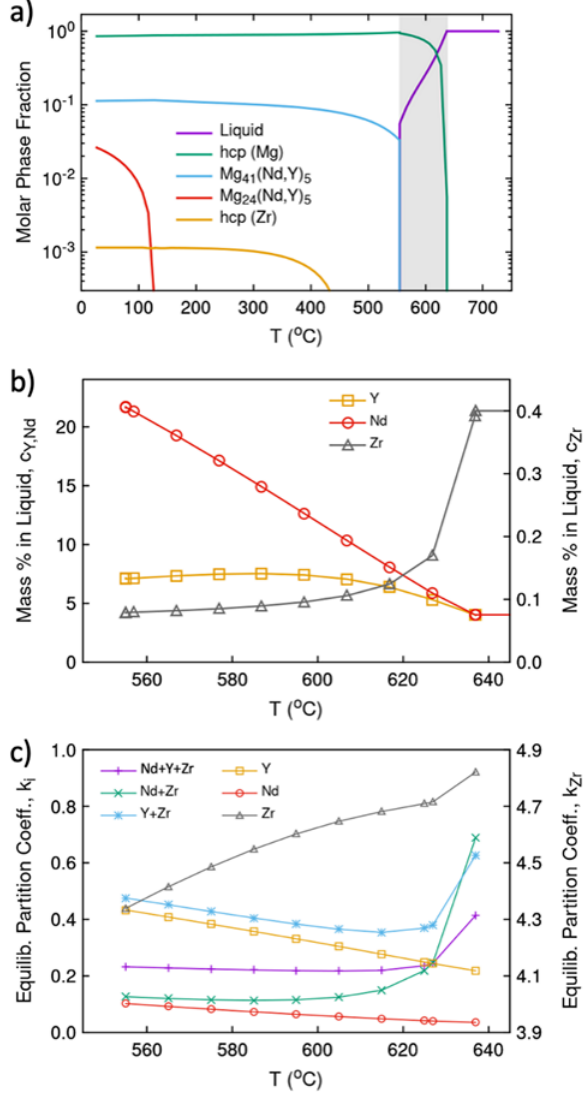
Figure 10. Computational thermodynamic analysis of WE43 solidification in equilibrium. ( a ) Property diagram showing molar-phase fractions, with the shaded area illustrating the solid–liquid coexistence region. ( b ) Elemental mass % on the liquid side of the solid–liquid interface. ( c ) Partition coefficient across the solid – liquid interface ( c s / c l ).